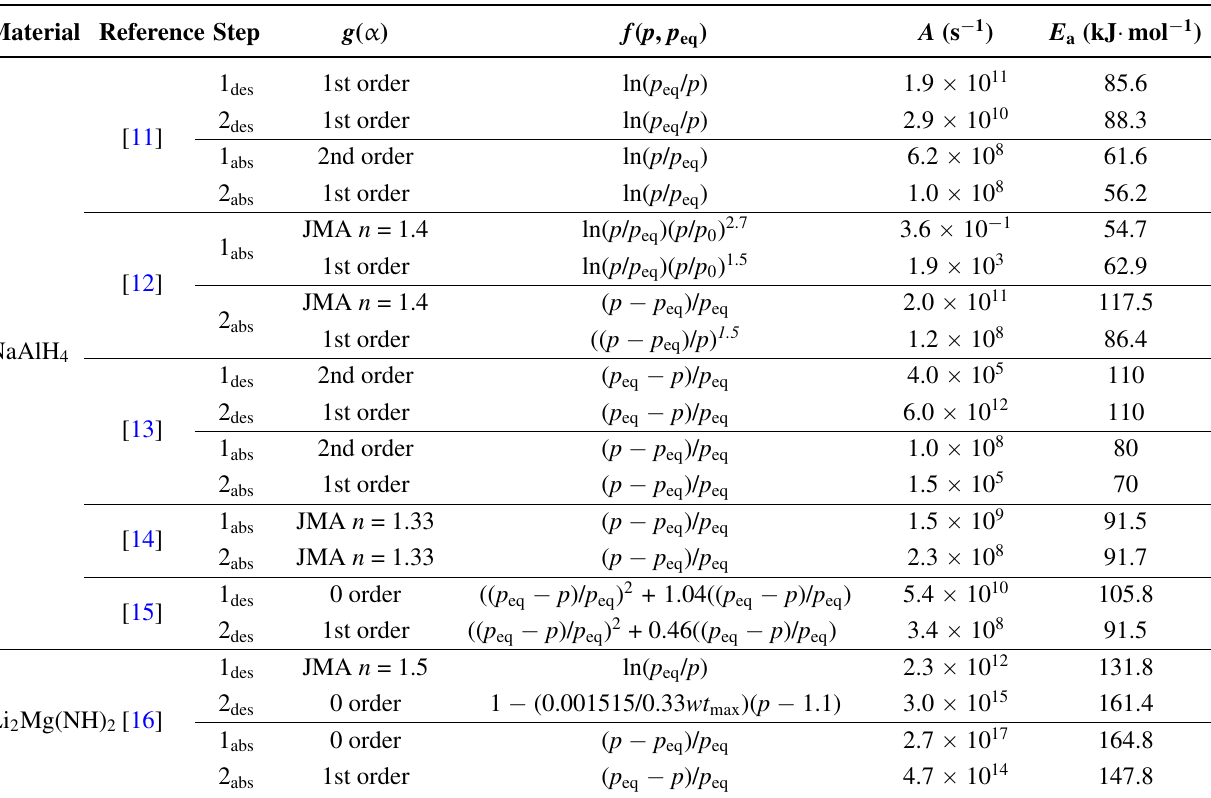
Table 2. Summary of the main kinetics models with pre-exponential factor A and activation energy E a